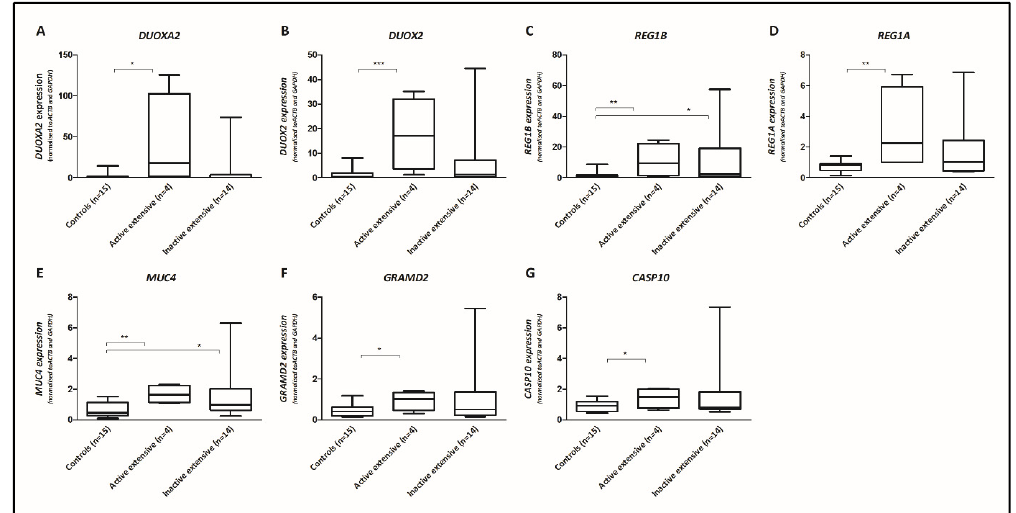
Log 2 fold-change and p corrected for the genes that were significantly dysregulated. Significantly dysregulated genes are indicated in bold. Results in ascending order of p -values of the comparison between the patients with active colitis and controls. UC, ulcerative colitis; vs, versus; FC, fold-change.